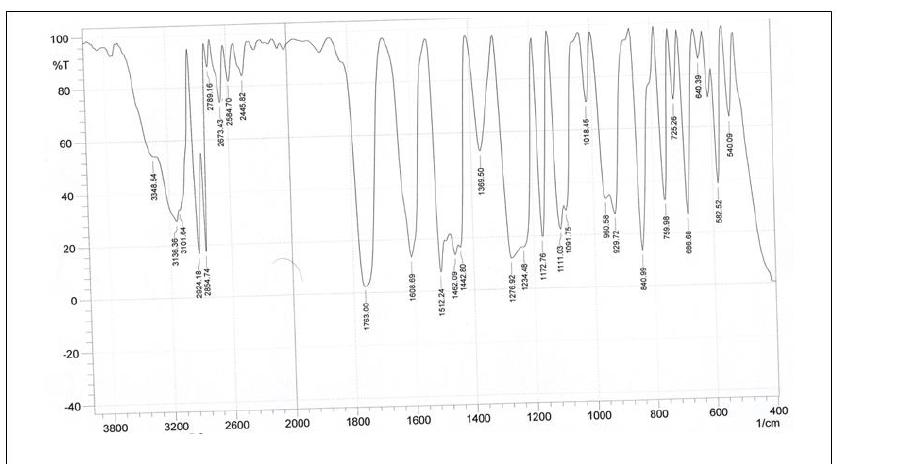
Fig. 4. FT-IR spectrum of PD